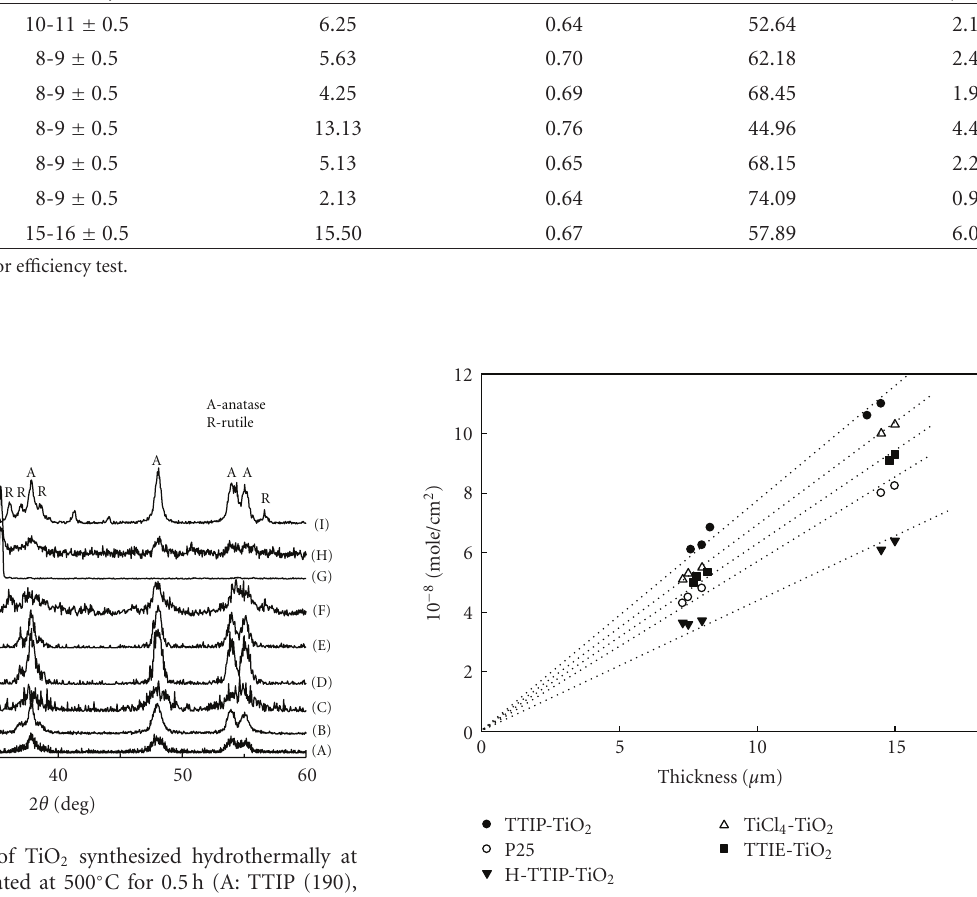
Figure 9: The amount of chemisorbed dye on the di ff erent thick- nesses.